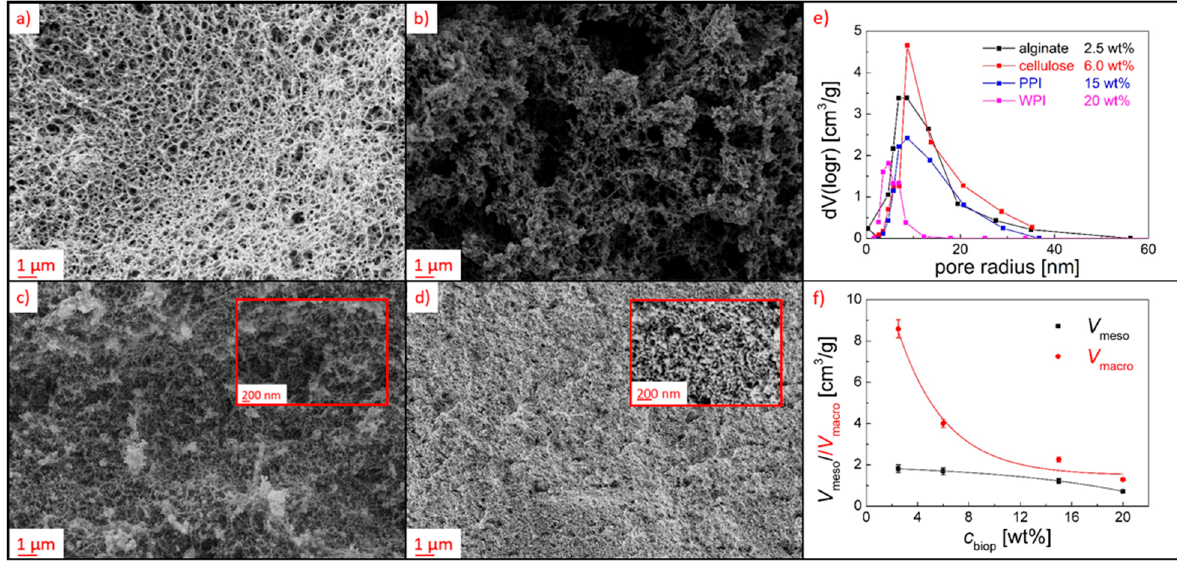
Figure 1. ( a – d ) SEM pictures of non-treated aerogels surfaces: ( a ) alginate, ( b ) cellulose, ( c ) PPI, ( d ) WPI, ( e ) pore size distributions, ( f ) macro- and mesopore volumes.